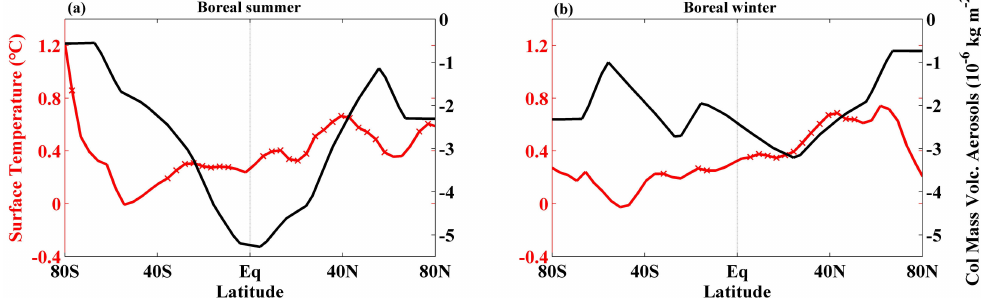
Figure 8. Meridional distributions of temperature and aerosols column density change. Shown are the difference between PWP and LIA of zonal-mean surface temperature (red line) and aerosols column density (black line) in the boreal summer ( a ) and boreal winter ( b ) under volcanic forcing. Statistical significance (10% significance level) based on t -test is indicated by red